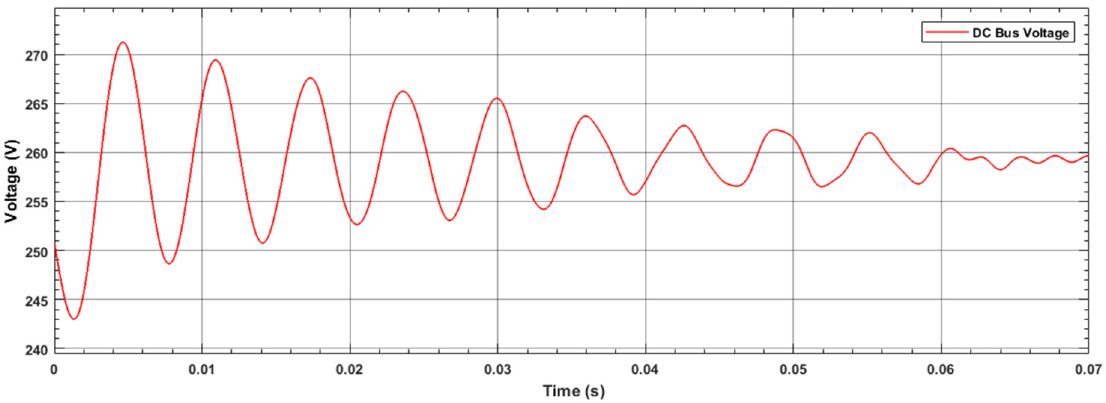
Figure 8. Boosted fuel cell output of DC bus.